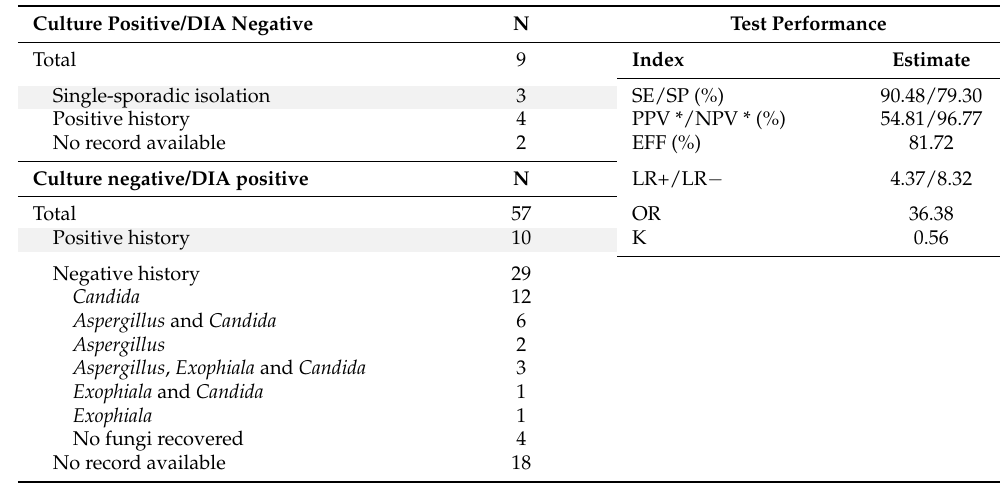
Table 2. Scedosporium / Lomentospora history of controversial samples (non-coincident result between culture and DIA test) and new test performance removing justified